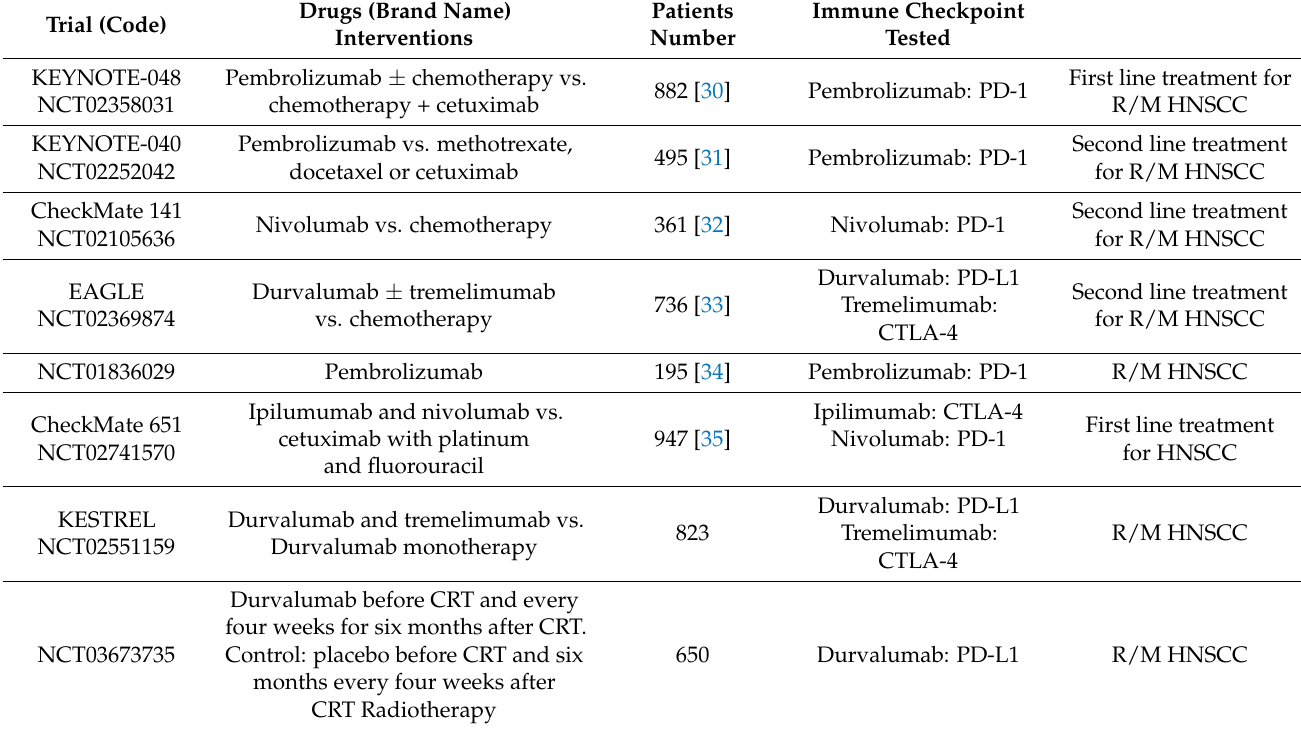
Table 1. Phase III trials evaluating alone or combination of immune checkpoint inhibitors in